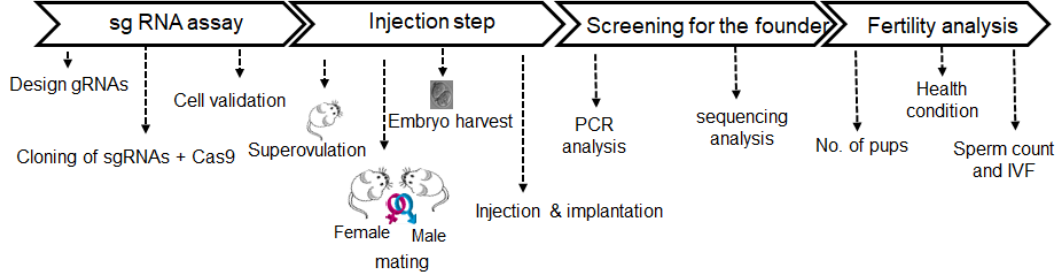
Figure 2. Overall strategy for the design, generation, and functional analysis of